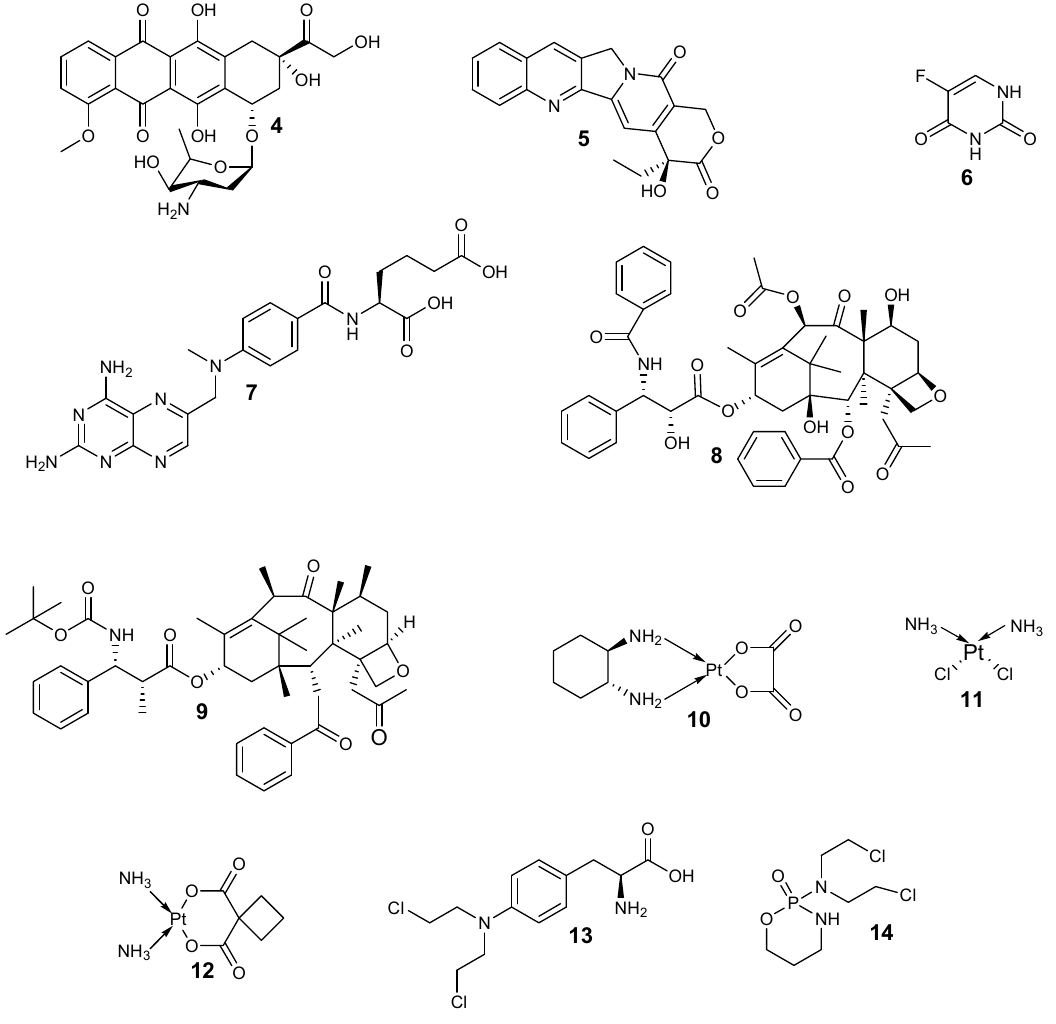
Figure 2. Chemical structure of anticancer drugs.